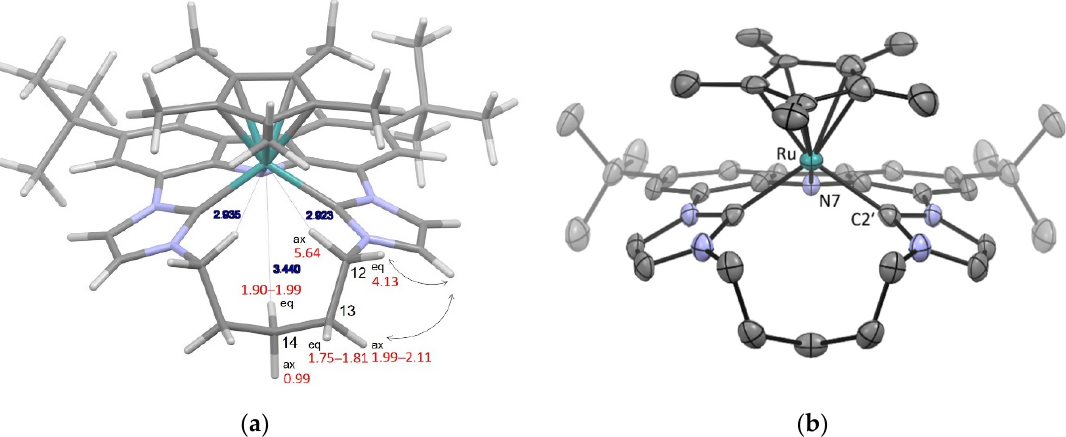
Figure 3. Molecular structure of complex 4 . ( a ) DFT-optimized structure showing the chemical shifts of the methylene signals (red) and important NOE cross peaks (black arrow) as well as the distance between the metal and close hydrogen atoms (blue); ( b ) ORTEP-style plot of the molecular structure of complex 4 (anisotropic atomic displacement parameters at the 50% probability level). Hydrogen atoms are omitted for clarity. The Cp* ligand is highly disordered.